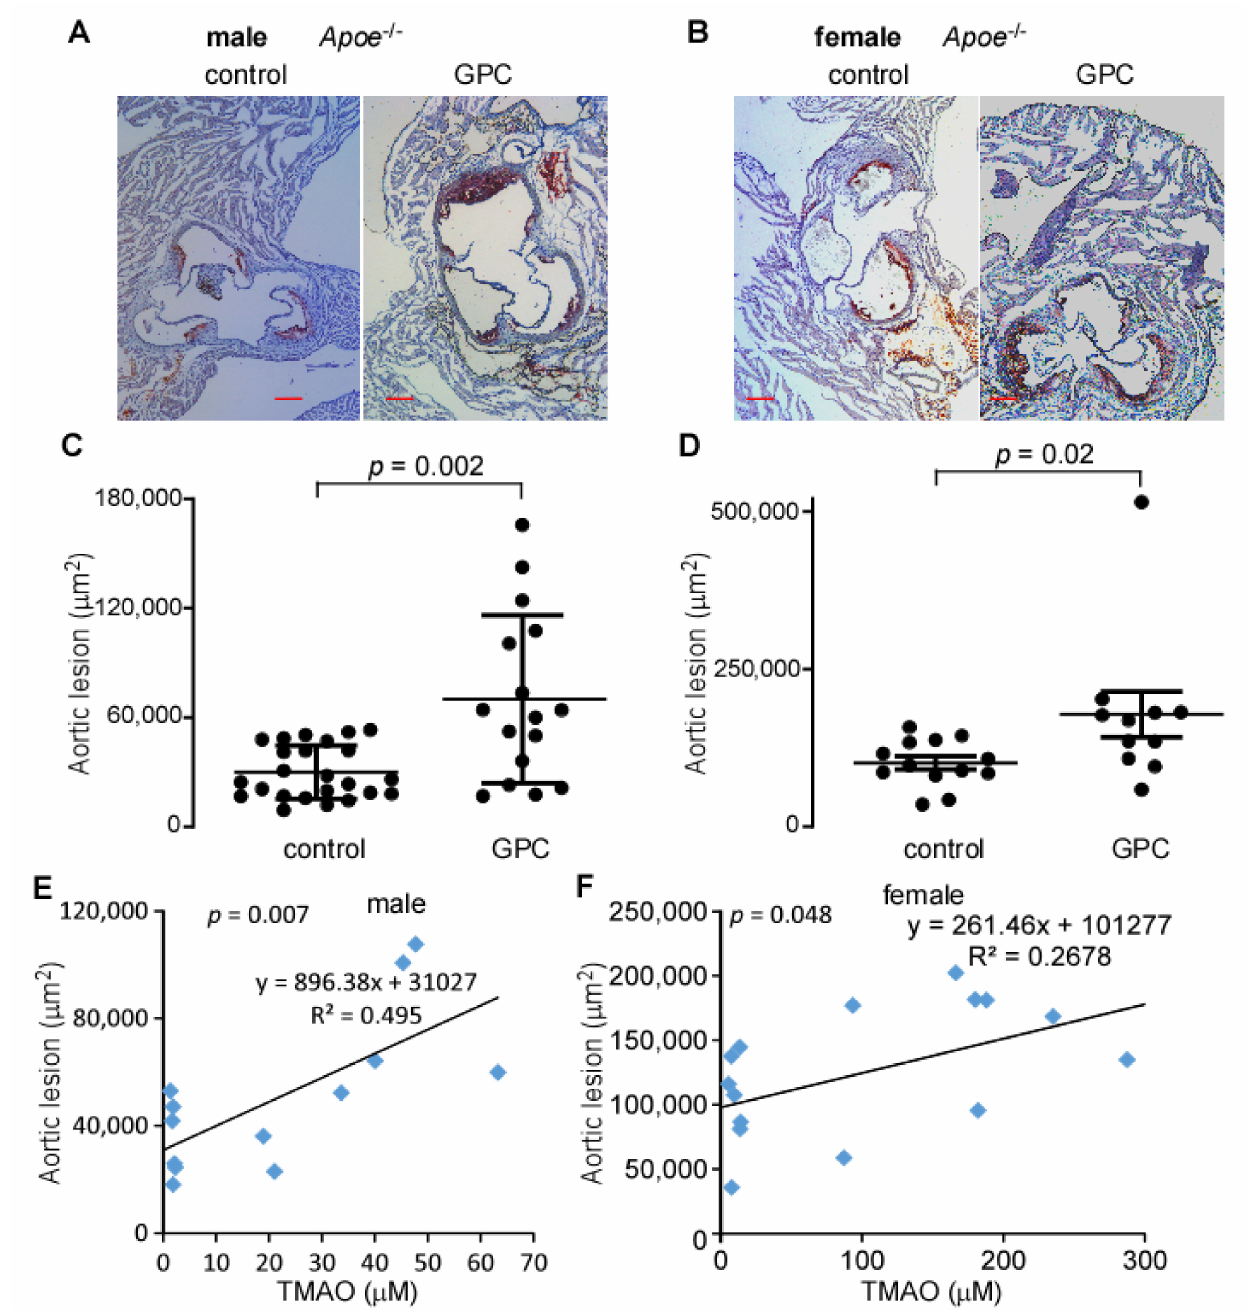
Figure 6. GPC promotes atherosclerosis. ( A , B ) Representative Oil-red-O/haematoxylin-stained aortic root sections from male ( A ) and female ( B ) C57BL/6J Apoe − / − mice fed control or GPC supplemented chow diets, scale bar = 0.2 mm. ( C , D ) Aortic lesion area in 20-week-old male ( C ) and female ( D ) C57BL/6J Apoe − / − mice fed GPC supplemented chow diet versus control chow diet. p values were calculated by Wilcoxon rank sum test. ( E , F ) Pearson correlation of aortic lesion to plasma TMAO in 20-week-old male and female C57BL/6J Apoe − / − mice fed either GPC supplemented chow diet or control chow diet for 16